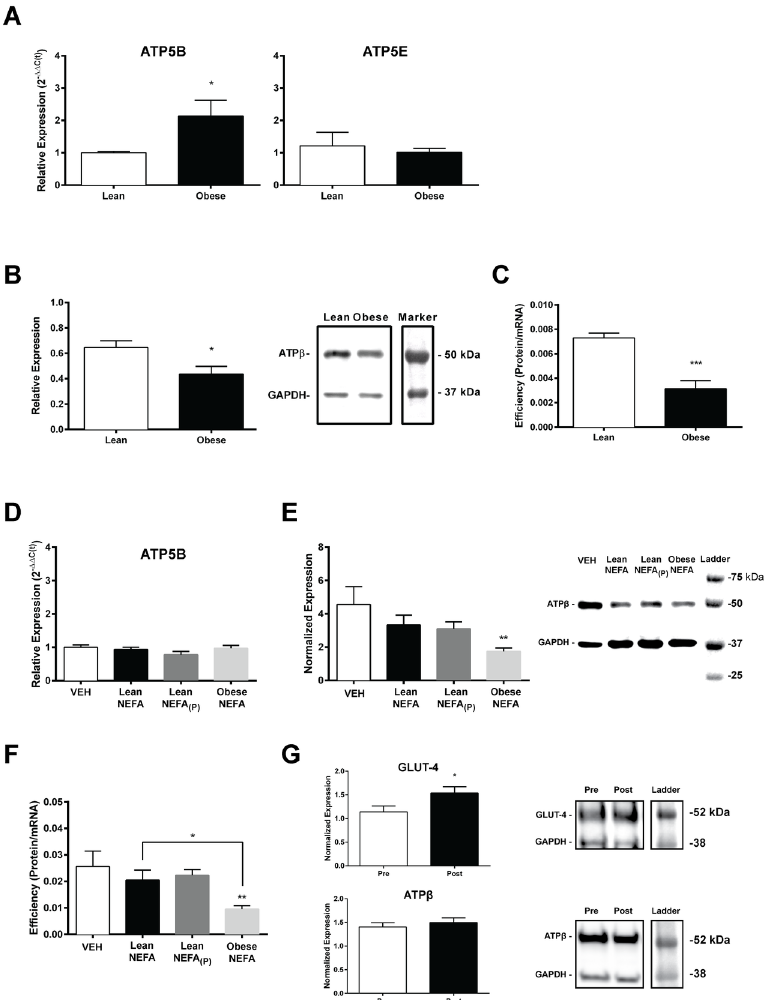
Fig 4. Quantification of ATP5B mRNA and β -F1-ATPase protein expression shows decreased protein translation in obesity. (A) The mRNA expression for ATP5B and ATP5E are shown, respectively. (B) Summary of β -F1-ATPase protein expression and representative blots are depicted. Positive bands for β - F1-ATPase are seen at ~56 kDa and for GAPDH at ~37 kDa. (C) Translation efficiency was compared between lean (n = 6) and obese (n = 7) subjects. Prolonged NEFA exposure on myotube β -F1-ATPase translation was determined in skeletal muscle explants (n = 6/group). (D) ATP5B mRNA was quantified for each NEFA-exposed group, (E) differences in β -F1-ATPase protein expression in response to NEFA exposure were observed, and (F) translation efficiency was calculated. (G) An additional myotube group was exposed to Obese NEFA (Pre) and then incubated for an additional five days in normal growth media (Post), and the cells were analyzed for GLUT-4 and β -F1-ATPase protein expressions. Data shown are means ± SE, and significance was * P < 0.05, ** P < 0.01, and *** P < 0.001 by Student ’ s unpaired t-test, or by one-way ANOVA with Tukey ’ s posthoc